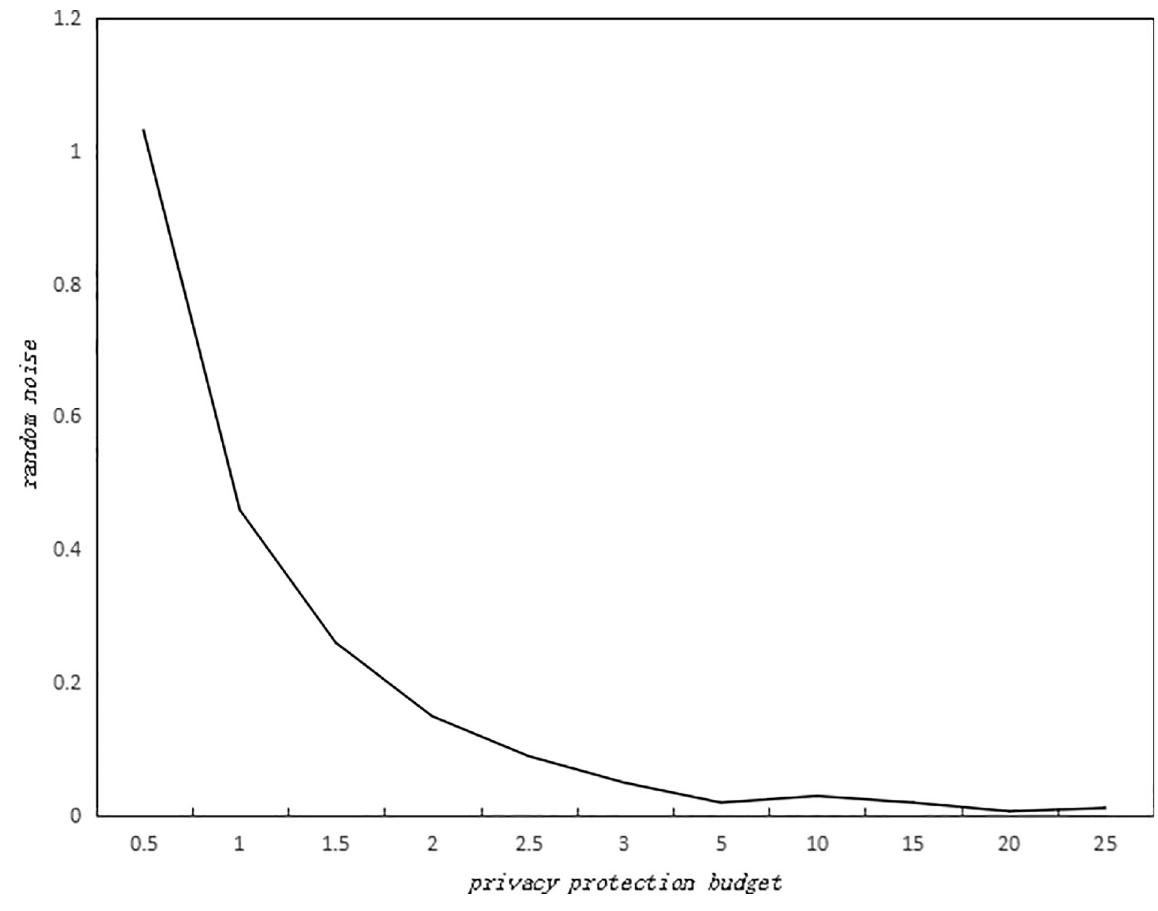
Fig 1. Effect of privacy budget on random